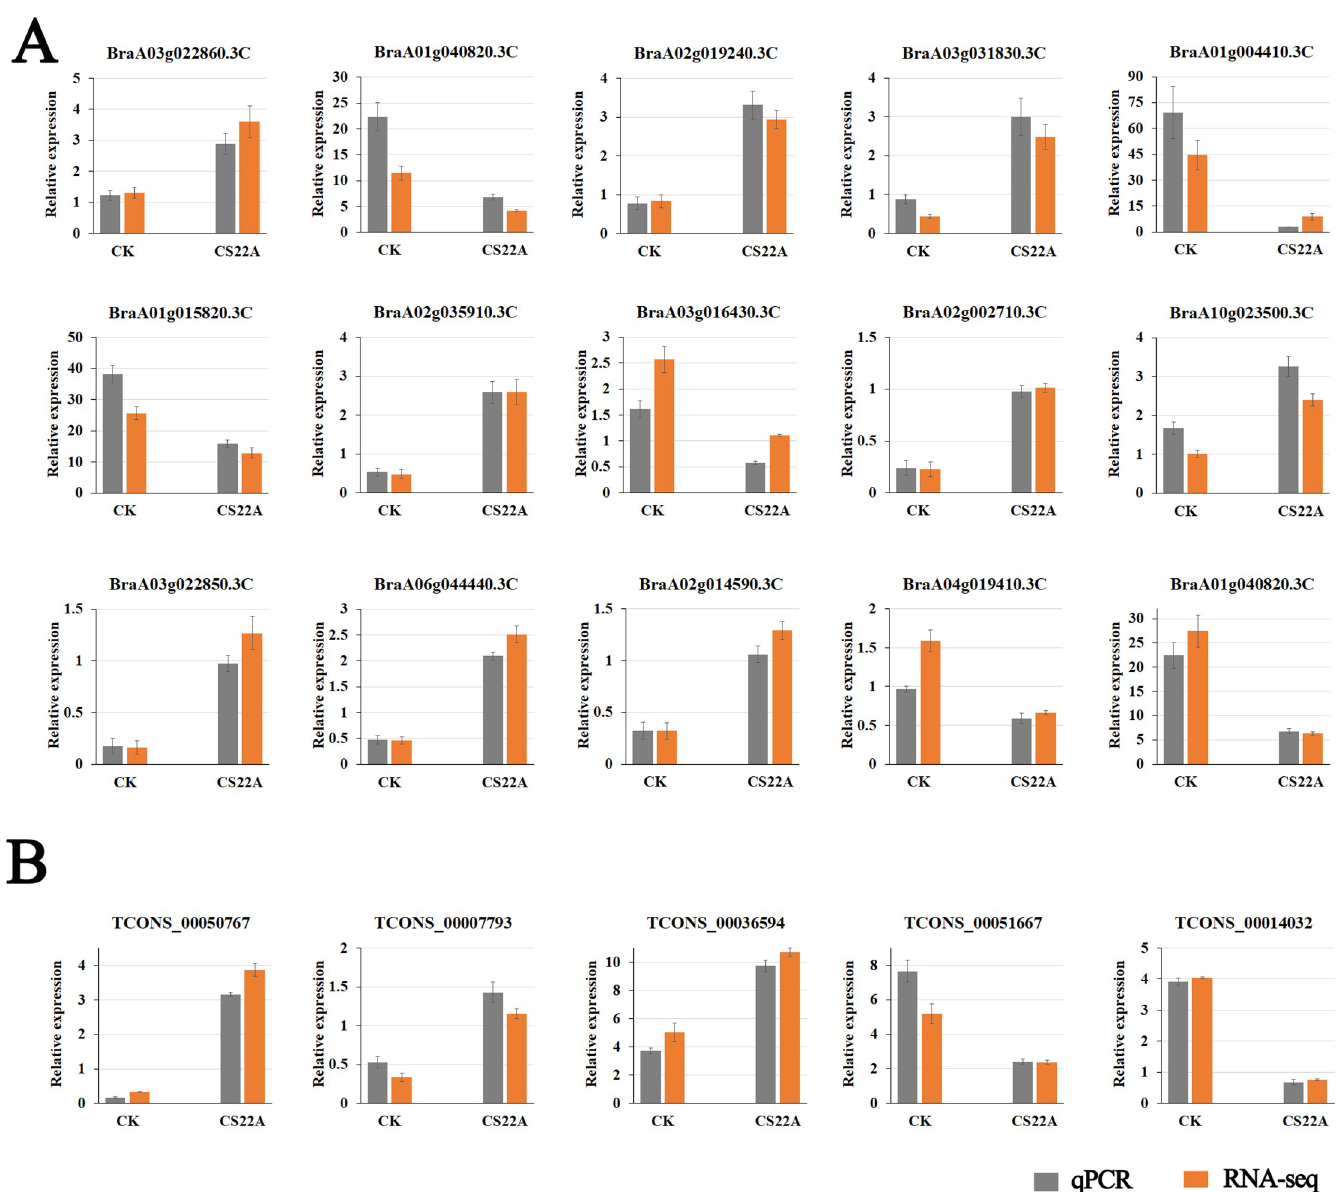
Fig 4. Randomly selected differentially expressed RNAs were analyzed using qRT-PCR. The expression level was normalized using TUB6 . Y-axis: the relative expression of selected genes compared with control as indicated. Data are shown as the mean ± standard deviation of three independent experiments.